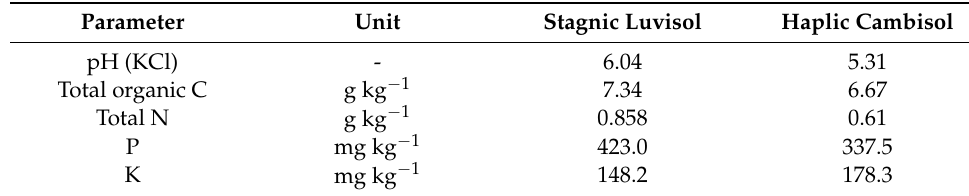
Table 1. The preceding crop was winter spelt ( Triticum spelta cv. ‘Frankenkorn’). Table 1. Characteristic of the